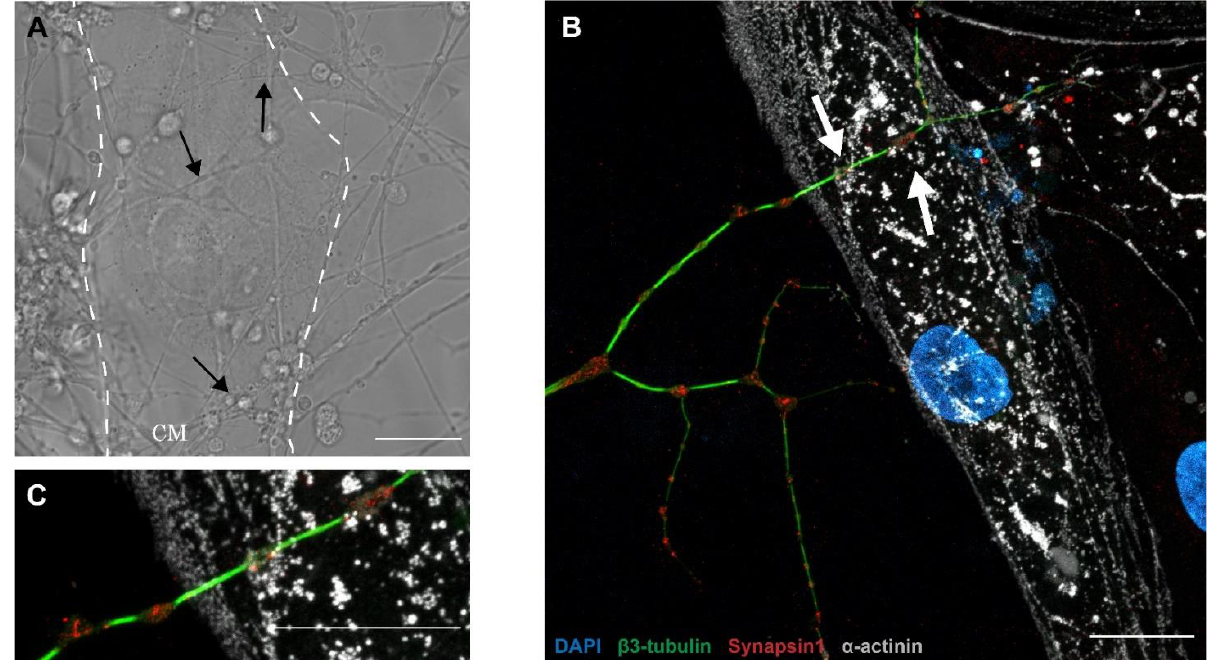
Figure 3. Structural characterization of the neuro–cardiac junction on a 14-day-old OOC. Images showing regions of local interaction between PC12 axons and hiPSC cm in transmission light (( A ), black arrows) or in immunofluorescence ( B ). PC12 neurites express the protein synapsin-1 colocalized with structural staining (β3 -tubulin; green, white arrows) in regions of interaction with cardiomyocytes and neurites. ( C ) Co-localization of tyrosine hydroxylase and synapsin-1 in the varicosities outside the neurocardiac junctions. (In this figure: blue: DAPI, red: synapsin- 1, green: β3 -tubulin, grey: sarcomeric α -actinin, scale bar: 20 µm.)